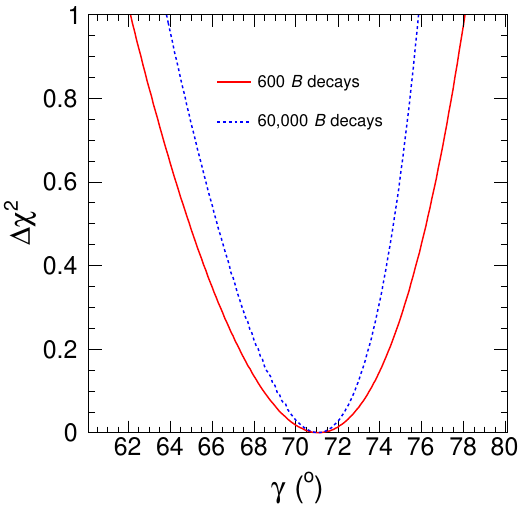
Figure 11 . The distribution of ∆ χ 2 vs. γ as fitted from two ensembles of simulated data sets, each data set containing 600 or 60,000 suppressed B